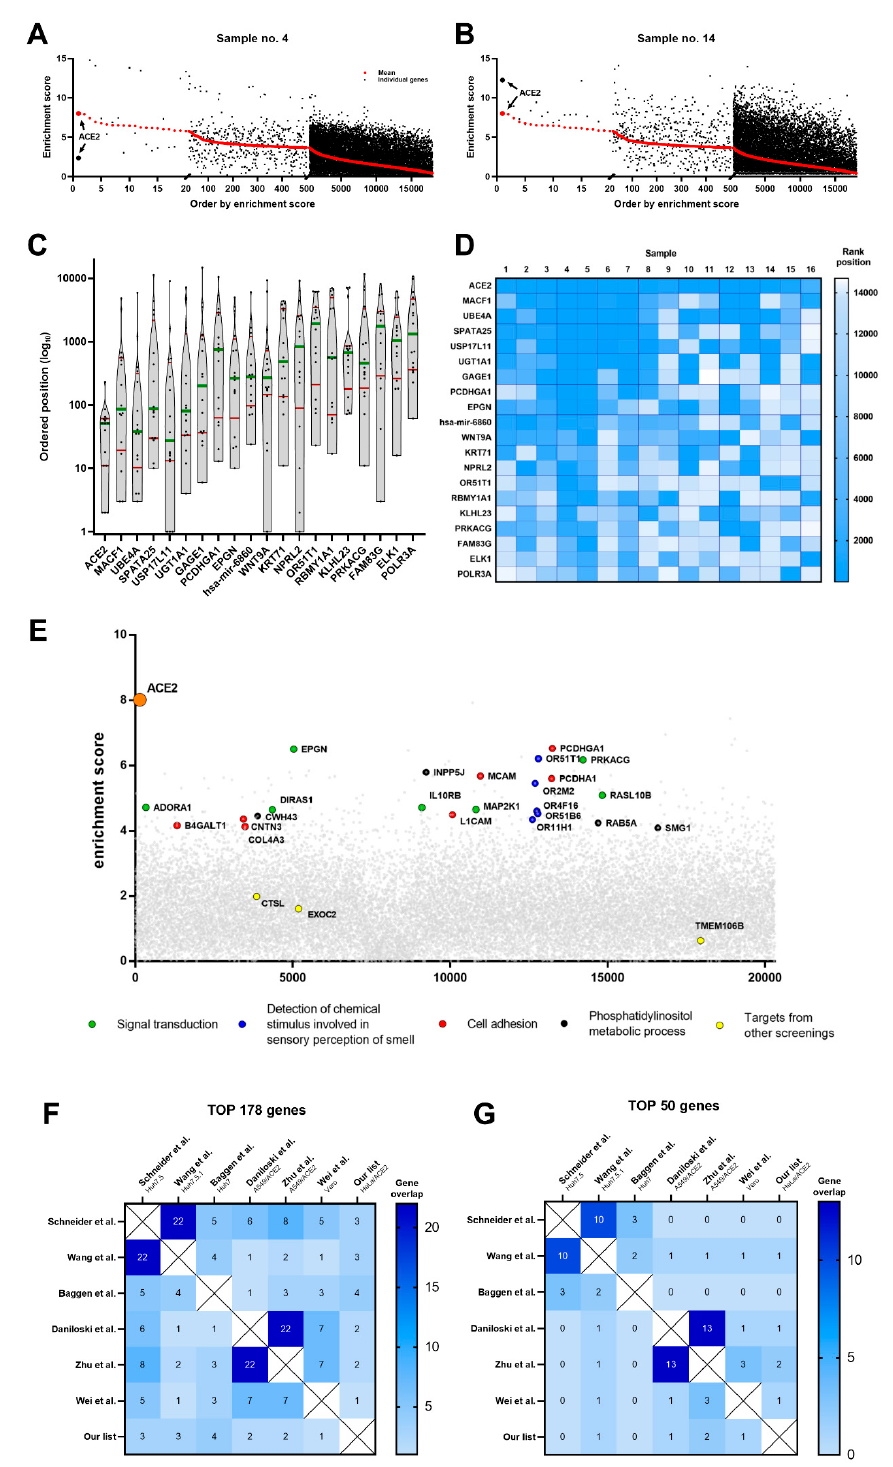
Figure 3. The selection of targets. ( A , B ) The distribution of sample-specific ranks genes. Bubble plots for gene distributions in two, representative samples, genes are ordered by mean enrichment score. ( C ) Violin plot for distribution of 20 top-ranked genes alongside the 16 biological repeats. Rank positions in single repeats were plotted, green line denotes median and red lines indicate interquartile range. ( D ) Heatmap for 20 top-ranked genes showing the rank position of individual samples. Top-ranked genes are ordered by the mean enrichment score. ( E ) Genome-wide CRISPR screening in HeLa ACE2 cells. Bubble plot of data from SARS-CoV-2 CRISPR screening, presenting distribution of genes in alphabetical order. Y-axis is presented as a mean of enrichment score from 16 independent screenings. ( F , G ) Heatmap for overlap of 178 and 50 top-ranked genes in our and other genome-wide CRISPR